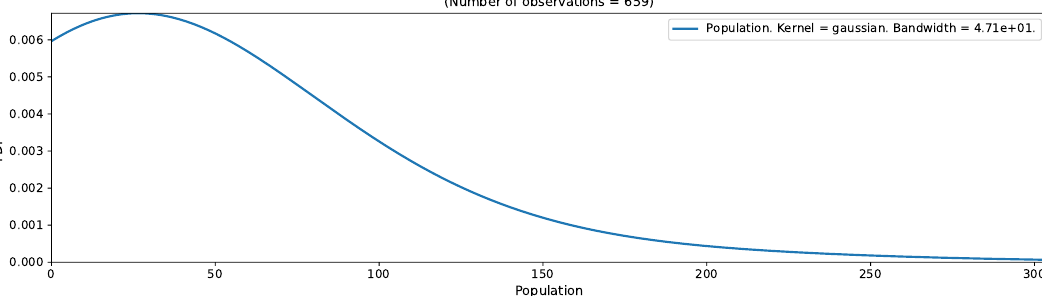
Figure 17. Estimated probability density function of a population threshold after which a non-urban pixel becomes urban in